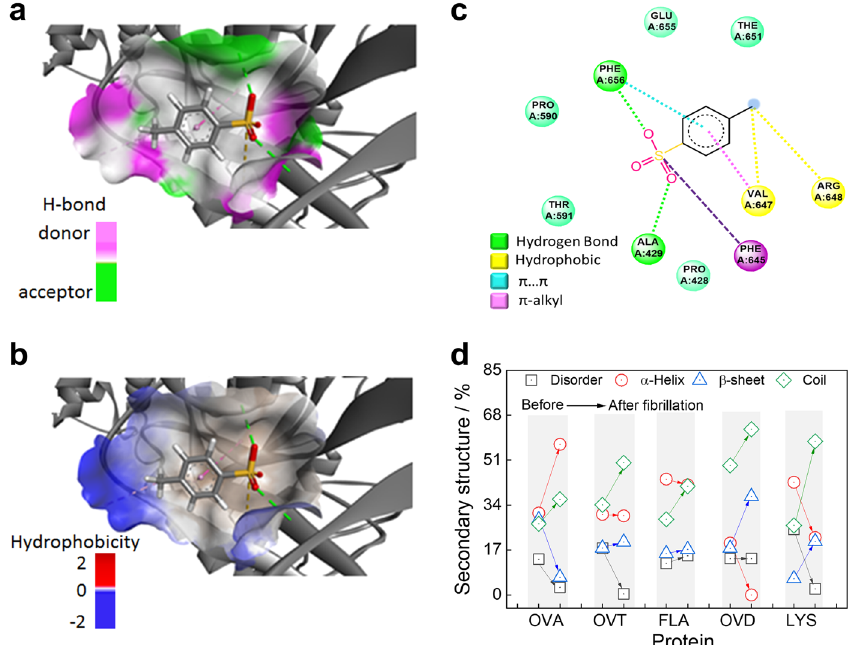
Fig. 5 Molecular docking and PASTA. Snapshots illustrating a hydrogen-bonding ability and b hydrophobicity of amino acids residues on docking pose with the lowest absolute value of af fi nity (kcal/mol) for Ovotransferrin with [Tos] − . c Molecular interaction diagrams of [Tos] − and amino acids residues of Ovotransferrin. d Changes in the secondary structural conformation of various proteins of EWP: Ovalbumin (OVA), Ovatransferrin (OVT), Flavoprotein (FLA), Ovamucoid (OVD), and Lysozyme (LYS) after fi brillation with